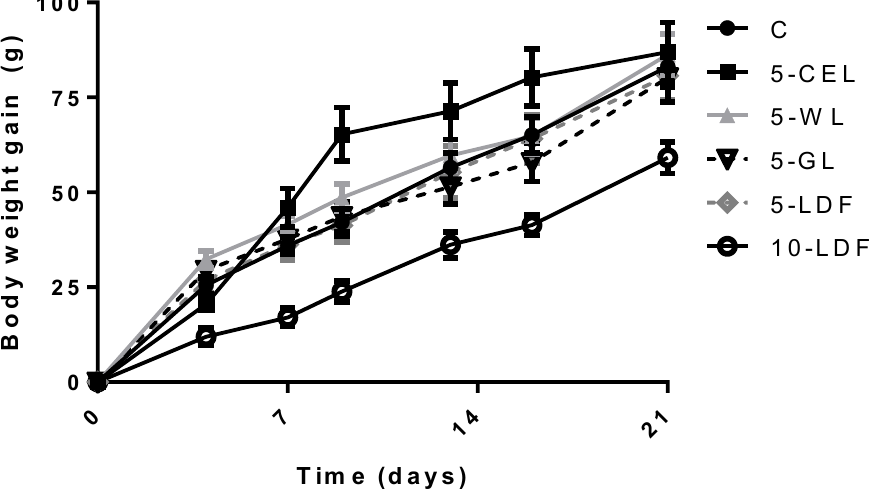
Figure 2. Weight gain during the 3 weeks feeding trial in rats fed six different diets (C = control; 5-CEL = 5% DF from cellulose; 5-WL = 5% DF from whole linseed; 5-GL = 5% DF from ground linseeds; 5-LDF = 5% DF from linseed DF extract; 10-LDF = 10% F from linseed DF extract) (Mean ± SE) ( n = 10). Significant overall effect of diet ( p = 0.001) and time ( p = 0.001) (repeated measures ANCOVA). Weight gain was significantly smaller in 10-LDF group compared to all other groups ( p = 0.02; repeated measures ANCOVA followed by least significance